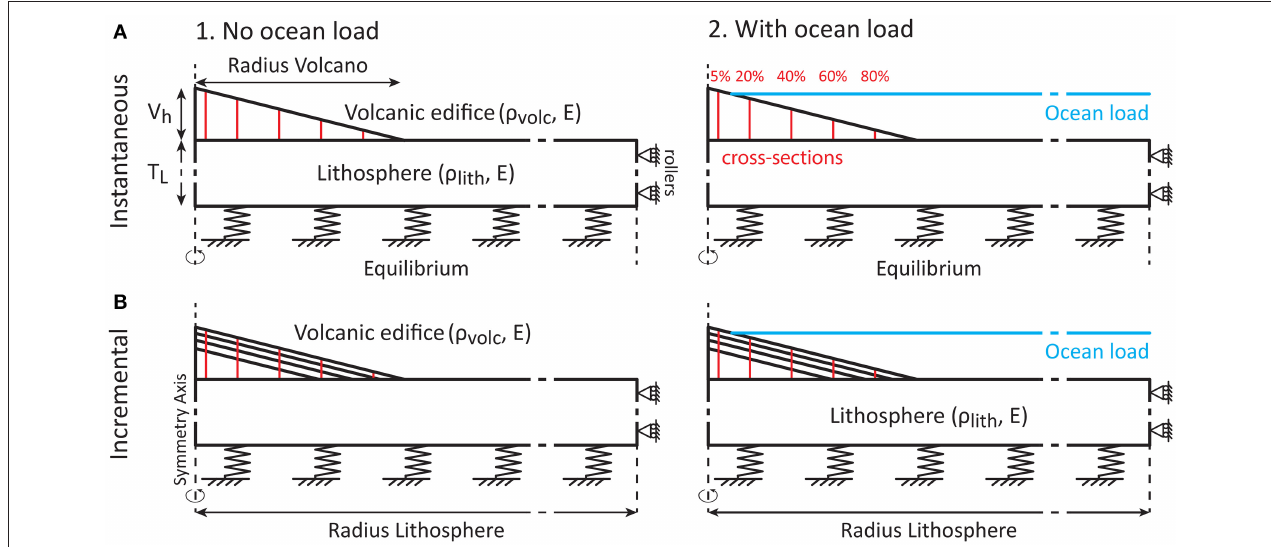
FIGURE 1 | Boundary conditions for the different axisymmetric finite element models (FEMs) used in this study. Initially, models are composed of an elastic lithosphere and an elastic volcanic edifice with or without an ocean load, with buoyant restoring forces applied at the base of the model and rollers applied to the right margin to constrain horizontal movements. Models are tested for a half-space geometry where T L = 1,000km, and a flexure geometry where T L = 30km. We studied two types of edifice growth: (A) an instantaneously-formed volcanic edifice, and (B) an incrementally-grown volcanic edifice consisting of layers of equal volumes as the initial edifice. In the models taking into account an ocean load, the ocean level varies from 1,000 to 7,000m in instantaneously-formed volcano models (A2), while it stays constant at 4,000m in incrementally-grown volcano models (B2). Cross-sections were created at 5, 20, 40, 60, and 80% of the resulting length of the volcanic edifice away from the symmetry axis ( Table S3 ). These cross-sections are used to plot the differential stress and the type of magmatic intrusions within the edifice (cf. Figures 3 , 5 , 7 ).